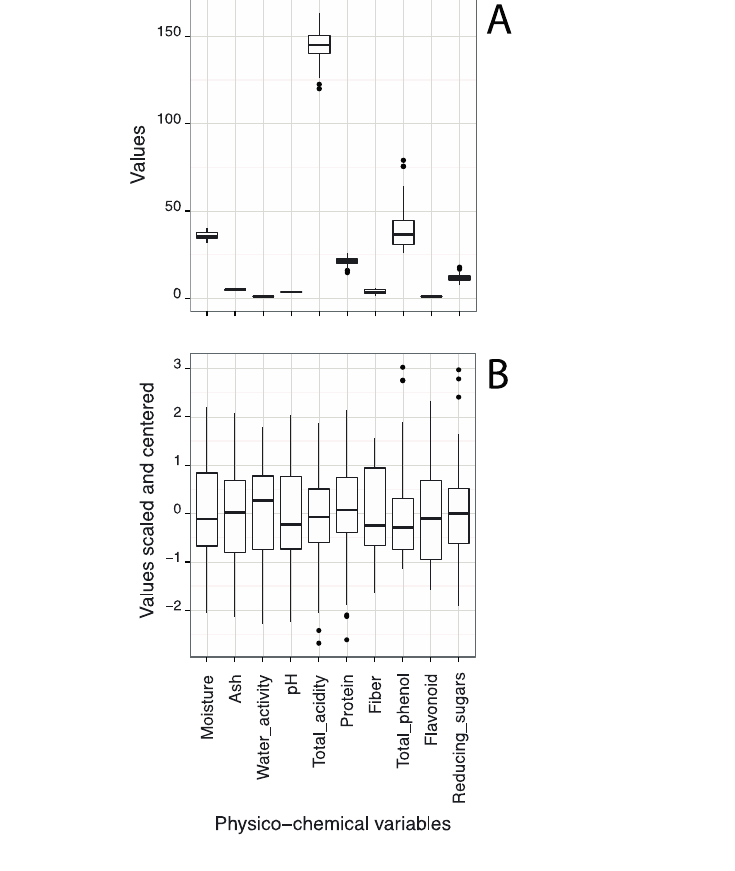
Figure 2. Two boxplot graphs of all physical and chemical parameters measured in the samples: ( A ) raw data; ( B ) centralized and standardized